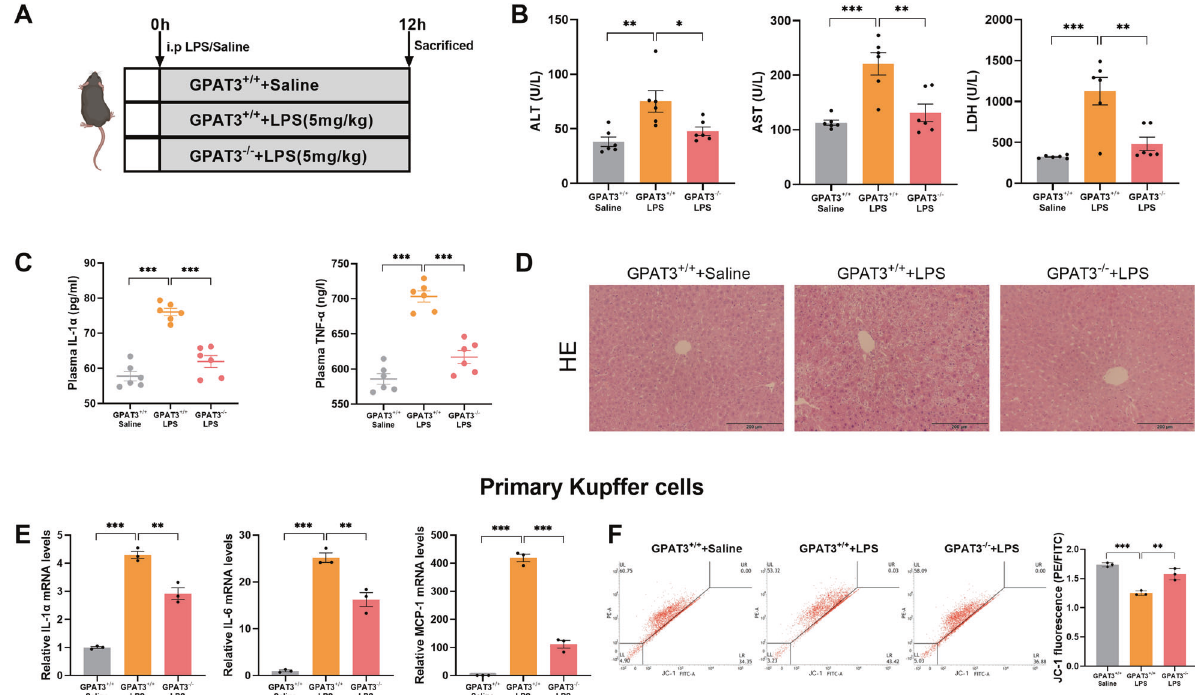
Fig. 4 GPAT3 deletion prevents LPS-induced hepatic injury and primary KCs in fl ammatory response. A Experimental design of LPS- induced in fl ammation model using GPAT3 + / + and GPAT3 -/- mice. B Plasma ALT, AST and LDH concentration of mice ( n = 6). C Plasma IL-1 β and IL-6 production of mice ( n = 6). D Representative images of HE staining (Scale bars represent 200 μ m) in liver of mice ( n = 3). E The mRNA levels of IL-1 α , IL-6 and MCP-1 in primary KCs ( n = 3). F Mitochondrial membrane potential in primary KCs ( n = 3). Data represents mean ± SEM. * P < 0.05, ** P < 0.01, *** P <